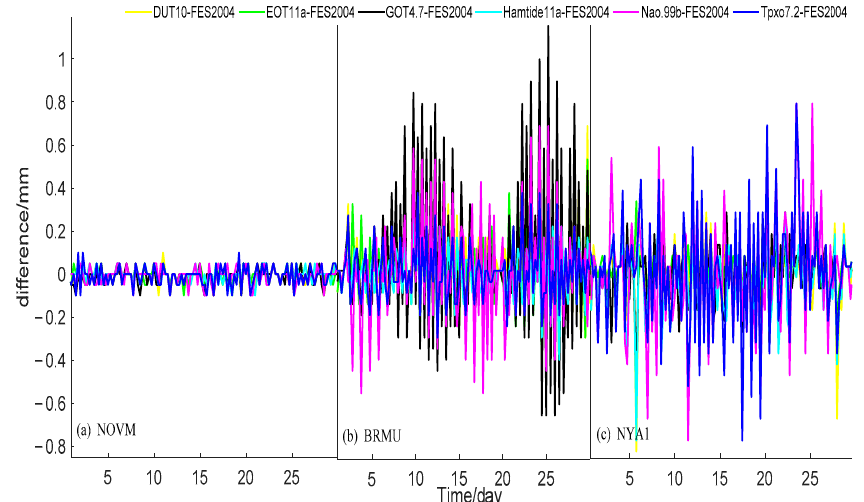
Figure 11. The difference of the ZTD calculated with the FES2004 model (as reference) and other OTL models at the ( a ) BRMU station, ( b ) NYA1 station, and ( c ) NOVM station.